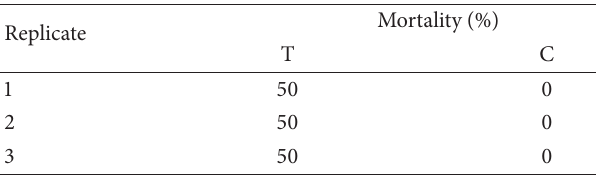
Table 2: Mortality of A. hydrophila infected hybrid catfish fed diets with and without L. plantarum C014. Replicate